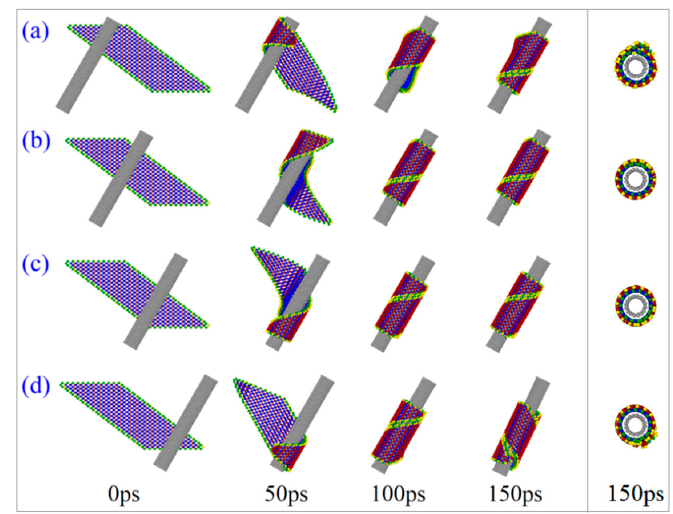
Figure 7. Snapshots in winding process of BP ribbons nearby the CNT (8, 8) with α = − 30 ◦ , but different values of L y. ( a ) L y = 0 nm. ( b ) L y = 3 nm. ( c ) L y = 6 nm. ( d ) L y = 9 nm.